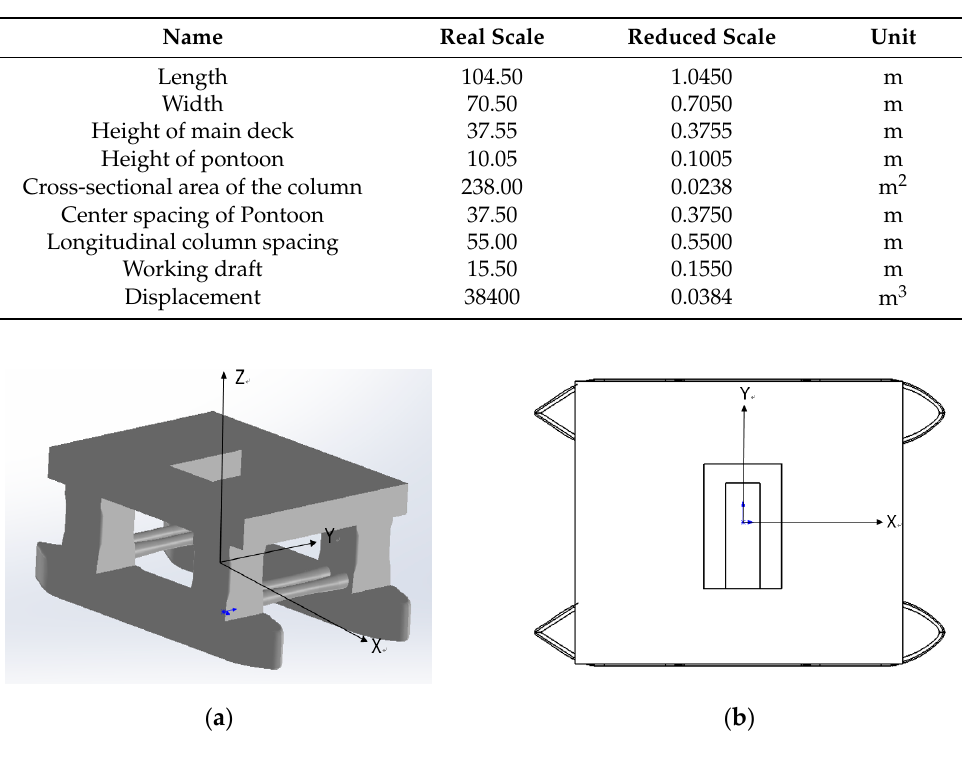
Figure 3. The three-dimensional schematic of the model and coordinates of the reference system are shown in ( a ), with the origin of the coordinates located at the center of gravity of the overall structure. The model’s weight is required to be similar to that of the prototype to meet the Froude number during the test: the draft and discharge of the model are regulated by ballast after the model is completed. Top view of the model was indicated in ( b ).